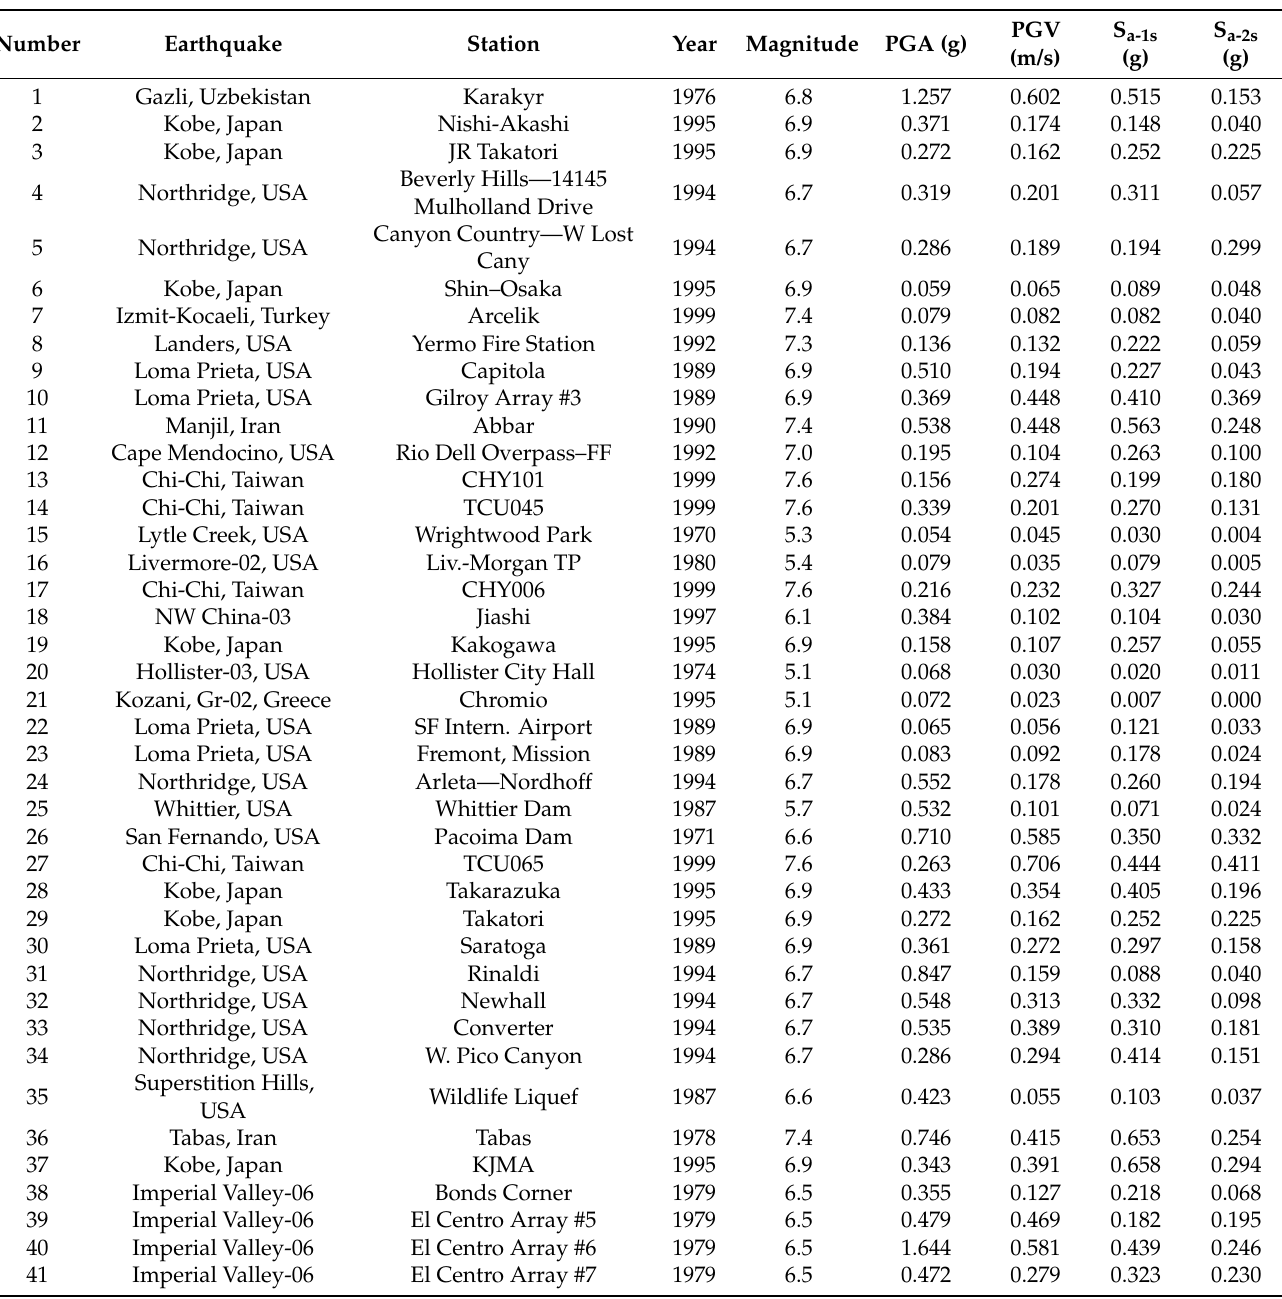
Table 3. Vertical ground motions used in this